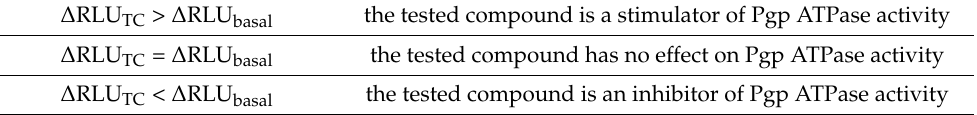
Table 2. Evaluation of Pgp ATPase